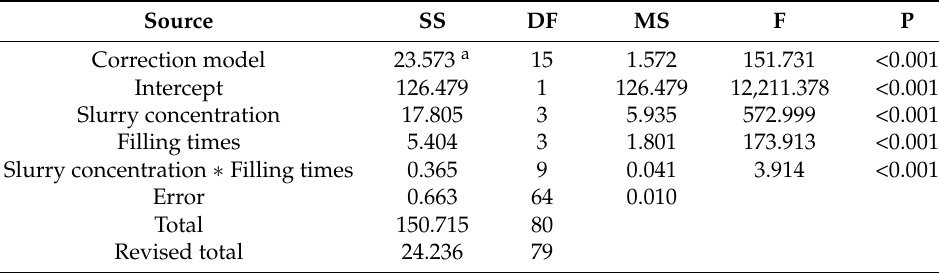
Table 3. Two-factor analysis of variance table.